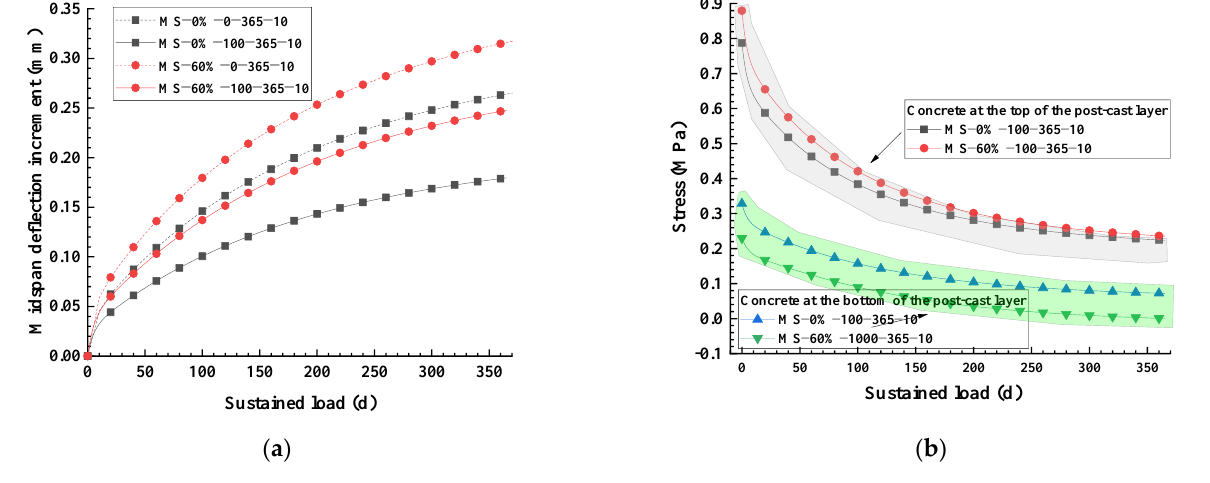
Figure 19. The creep of the concrete with different heights of reinforcement under a negative bending moment: ( a ) midspan deflection increment and ( b ) the section stress.